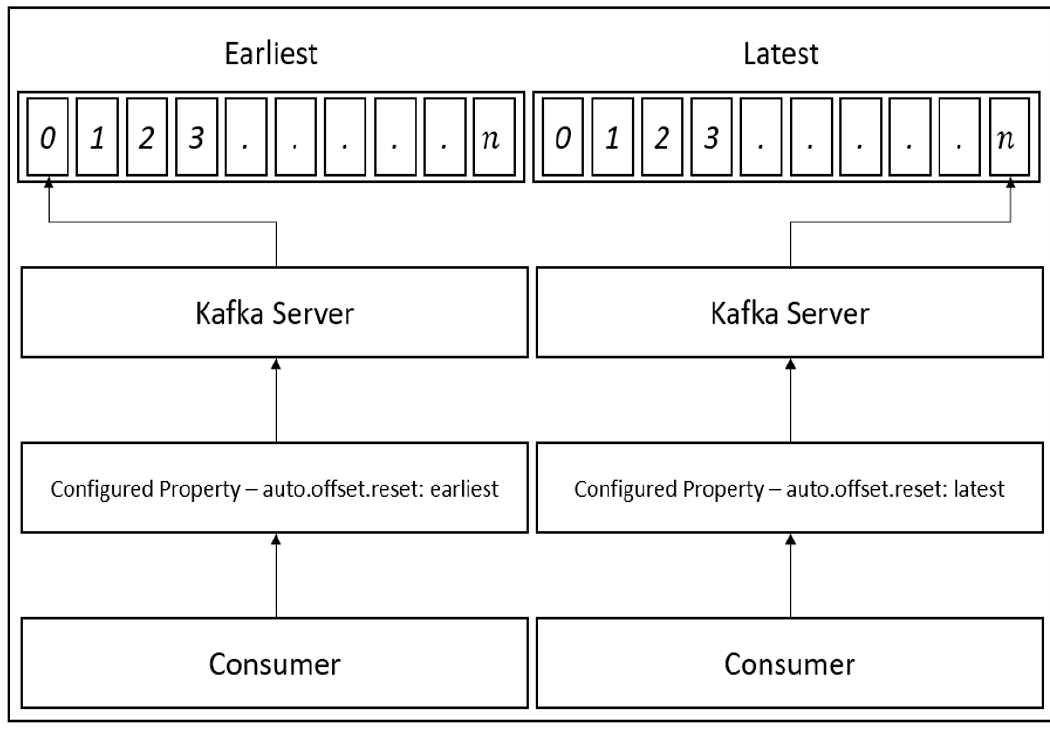
Figure 4. Kafka Offset Configurations and